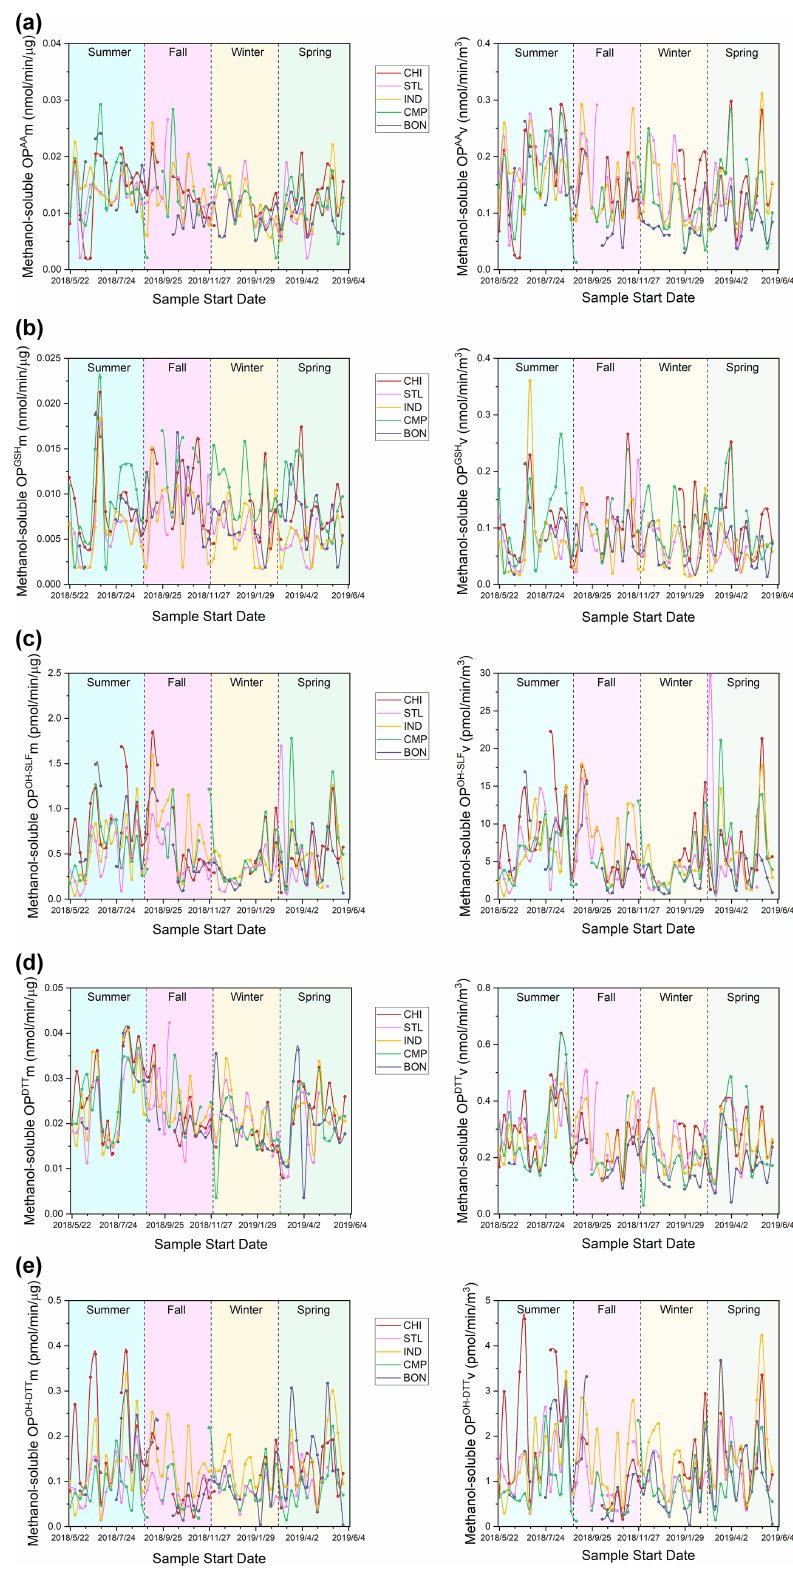
Figure 4. Time series of mass-normalized (left) and volume-normalized (right) methanol-soluble OP activities for (a) OP AA , (b) OP GSH , (c) OP OH − SLF , (d) OP DTT , and (e) OP OH − DTT at our sampling sites.